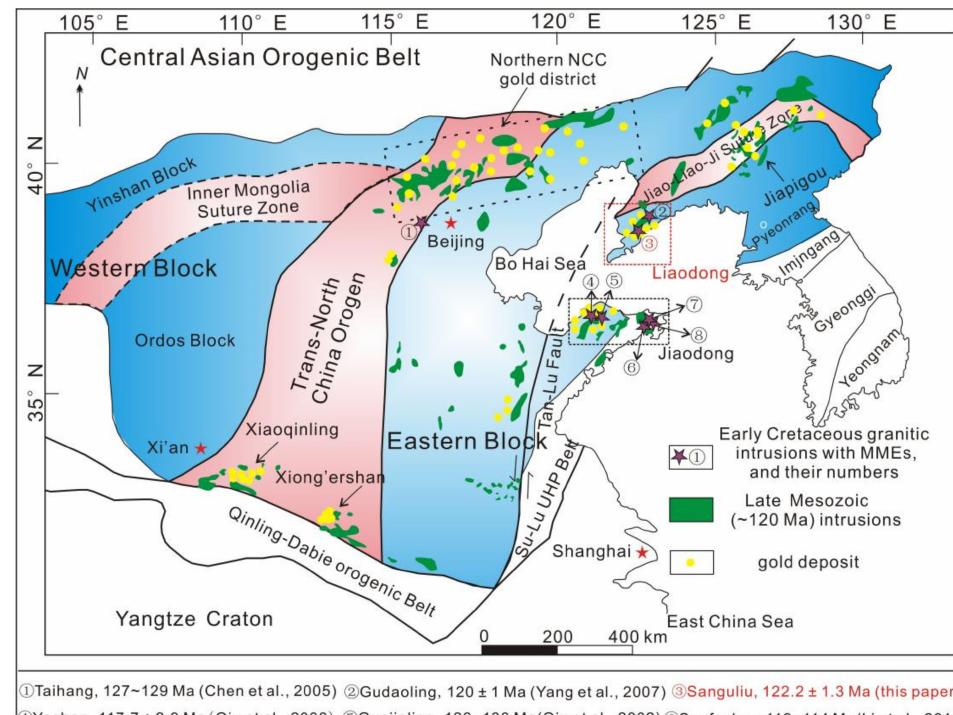
Figure 1. Tectonic location and division of the North China Craton (the zircon U–Pb ages from [6,8,11,20–23], modified from [24]). The locations of the mapped areas in Figure 2 have been marked by the red